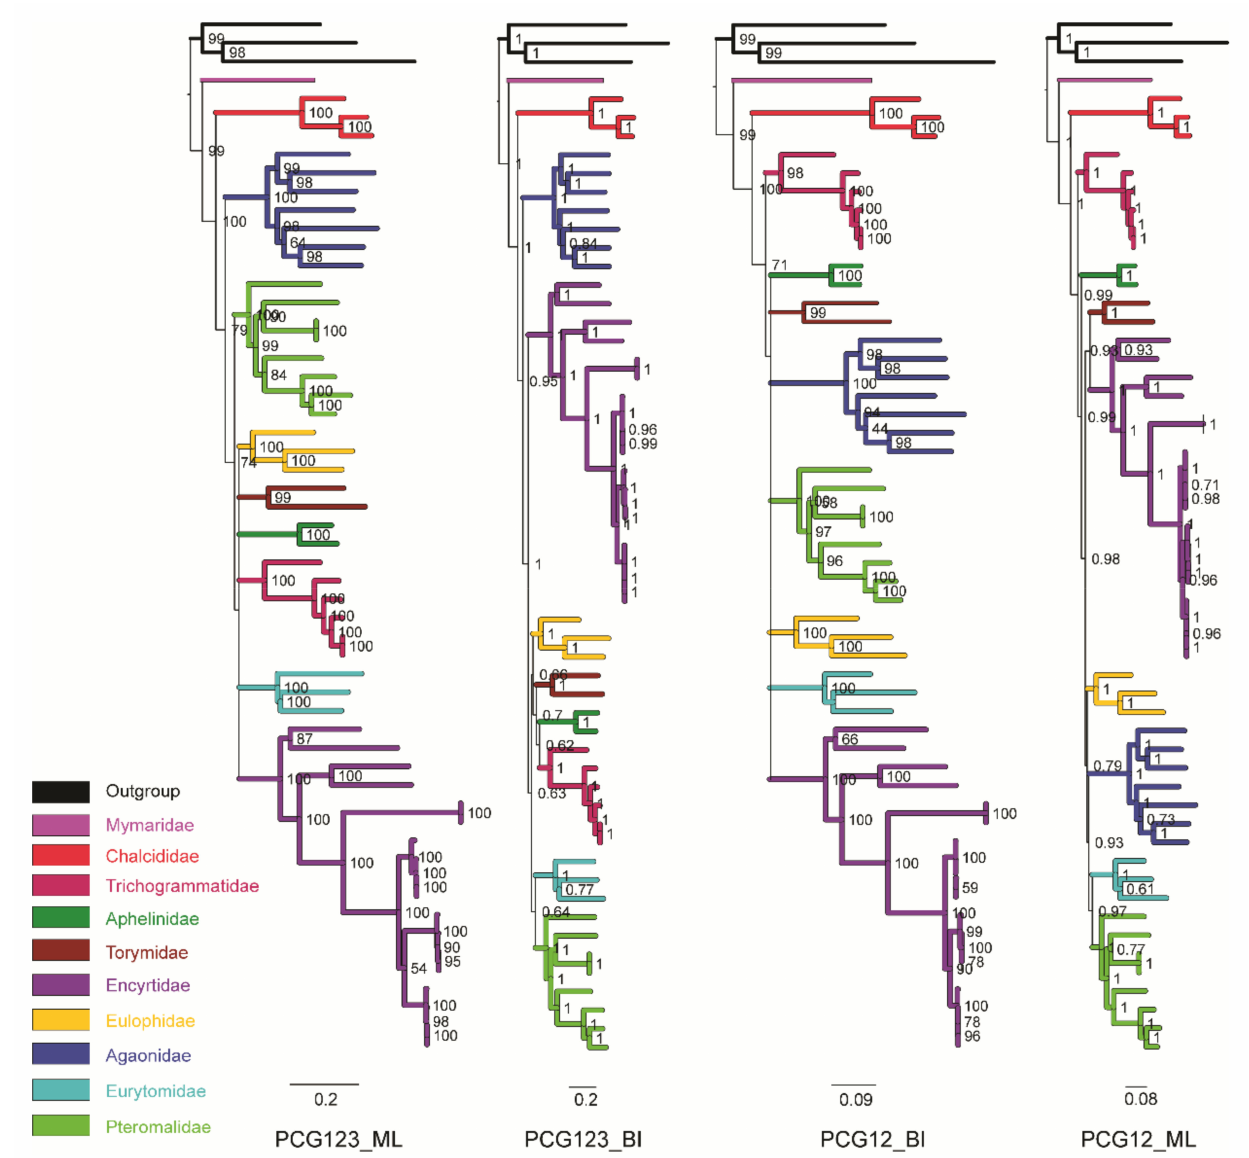
Figure 4. Phylogenetic trees constructed by ML/BI methods based on the dataset of PCG123 and PCG12. In the ML tree, all nodes of bootstrap value lower than 50 were shown as